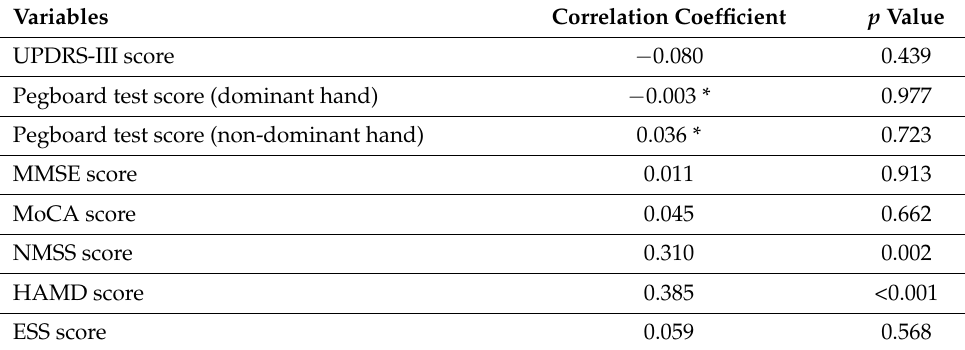
Table 3. Correlations between the FSS score and clinical